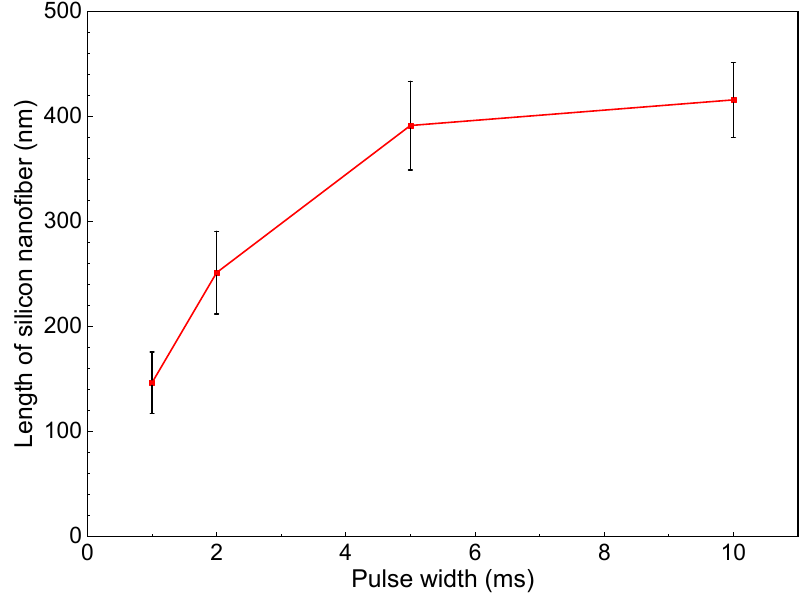
Figure 7. Change in length of silicon nanofibers with pulse width.